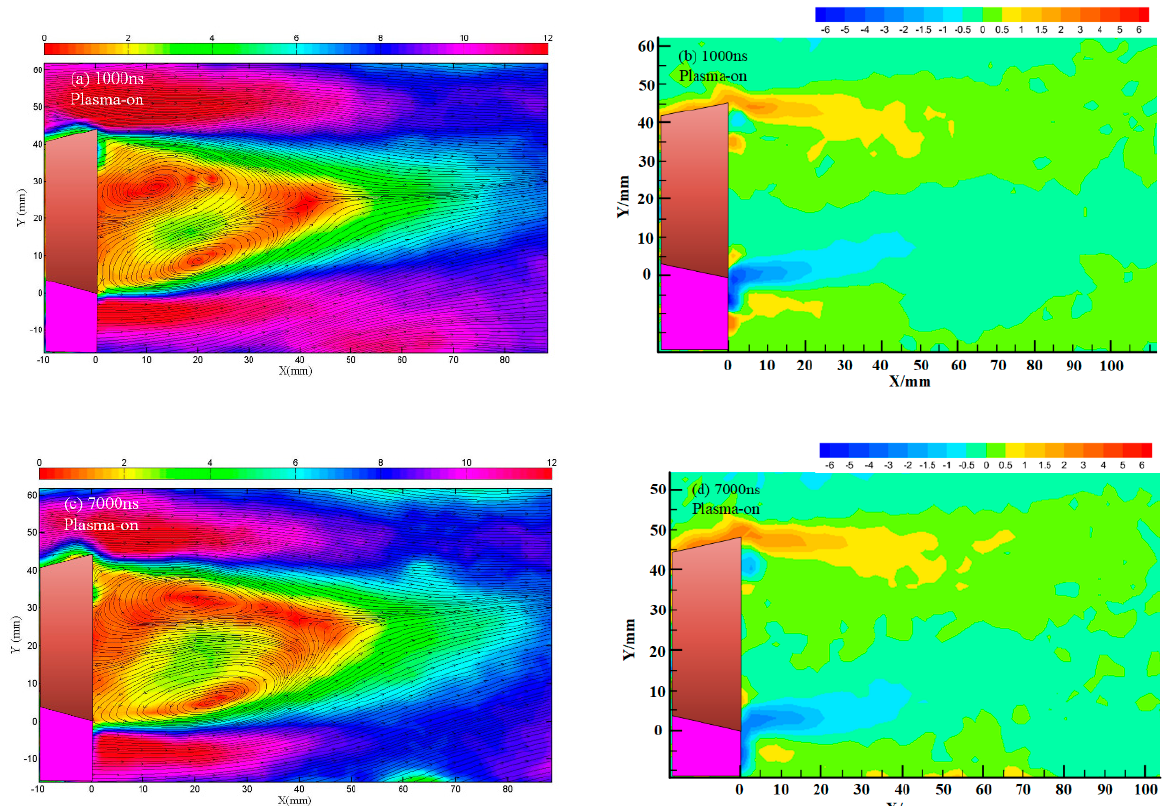
Figure 19. Time-averaged flow structures ( left ) and vorticity contours ( right ) of the flame-holder wake for different pulse widths, ( a , b ) 1000 ns pulse width, ( c , d ) 7000 ns pulse width.